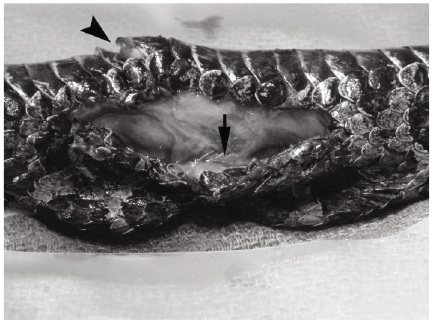
Figure 5: Postoperative photograph showing incorporation of expanded lateral skin into an osteosarcoma excision site in a Massasauga rattlesnake ( Sistrurus catenatus ).